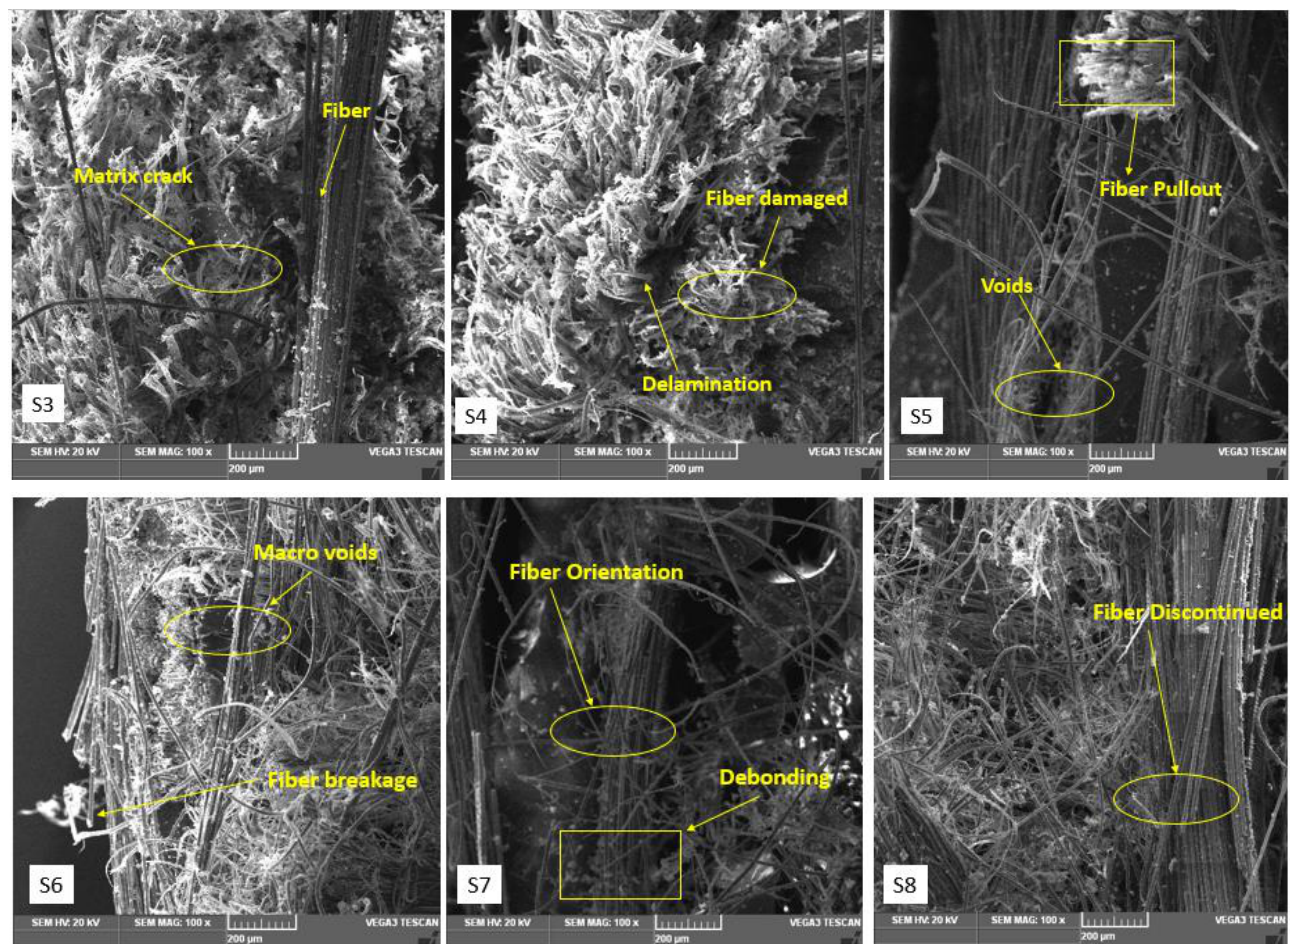
Figure 14. SEM images of S3, S4, S5, S6, S7 and S8 tensile fracture specimens.